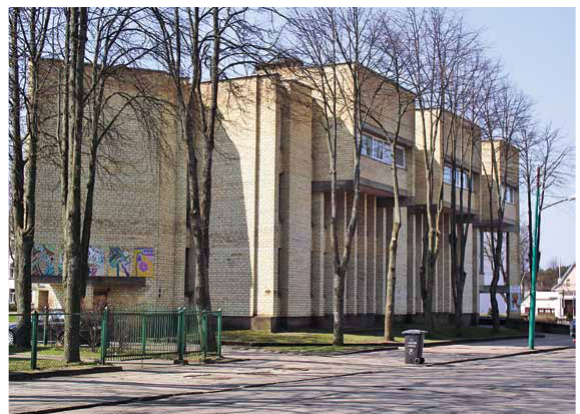
Fig. 2. The elementary school, Virbališkės takas 4,